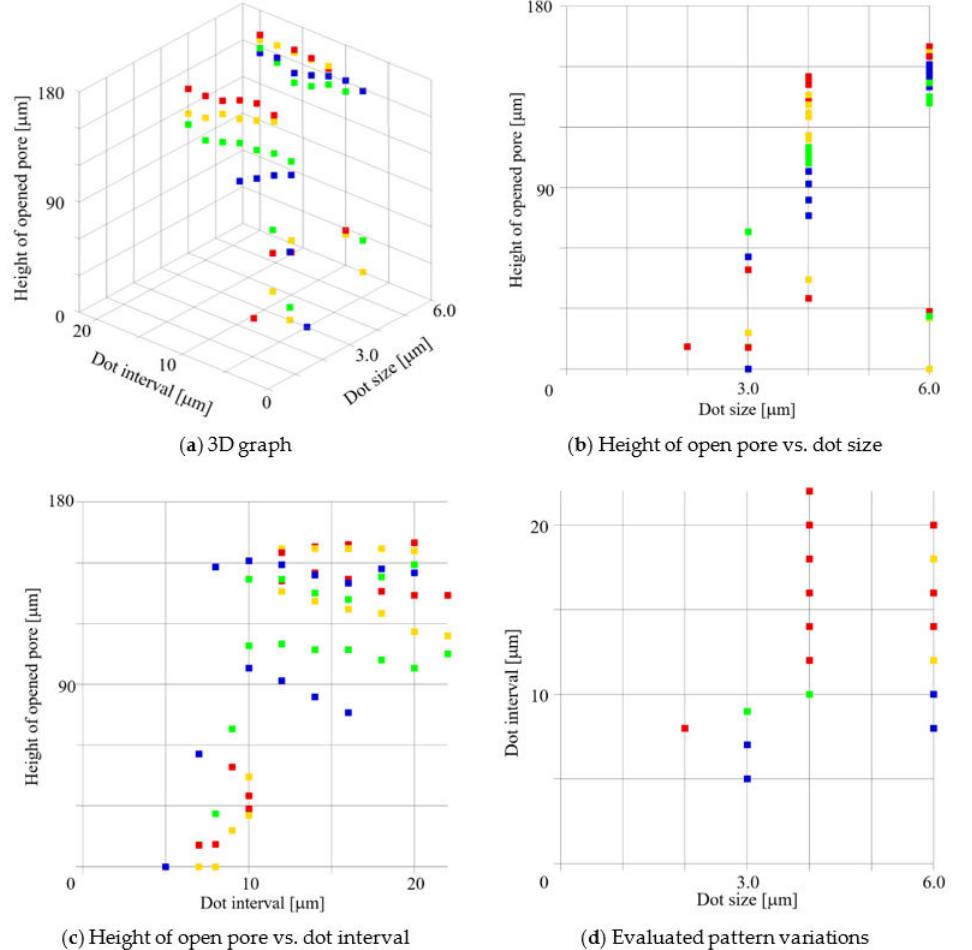
Figure 6. Height of the open pores from the substrate as a function of the dot size, interval, and exposure dose. The X axis is the dot size, Y axis is the dot interval, and Z axis is the distance from the substrate to the open pore. The color of each point indicates the exposure dose. The blue, green, yellow, and red points are 300, 400, 500, 600 mJ/cm 2 ,